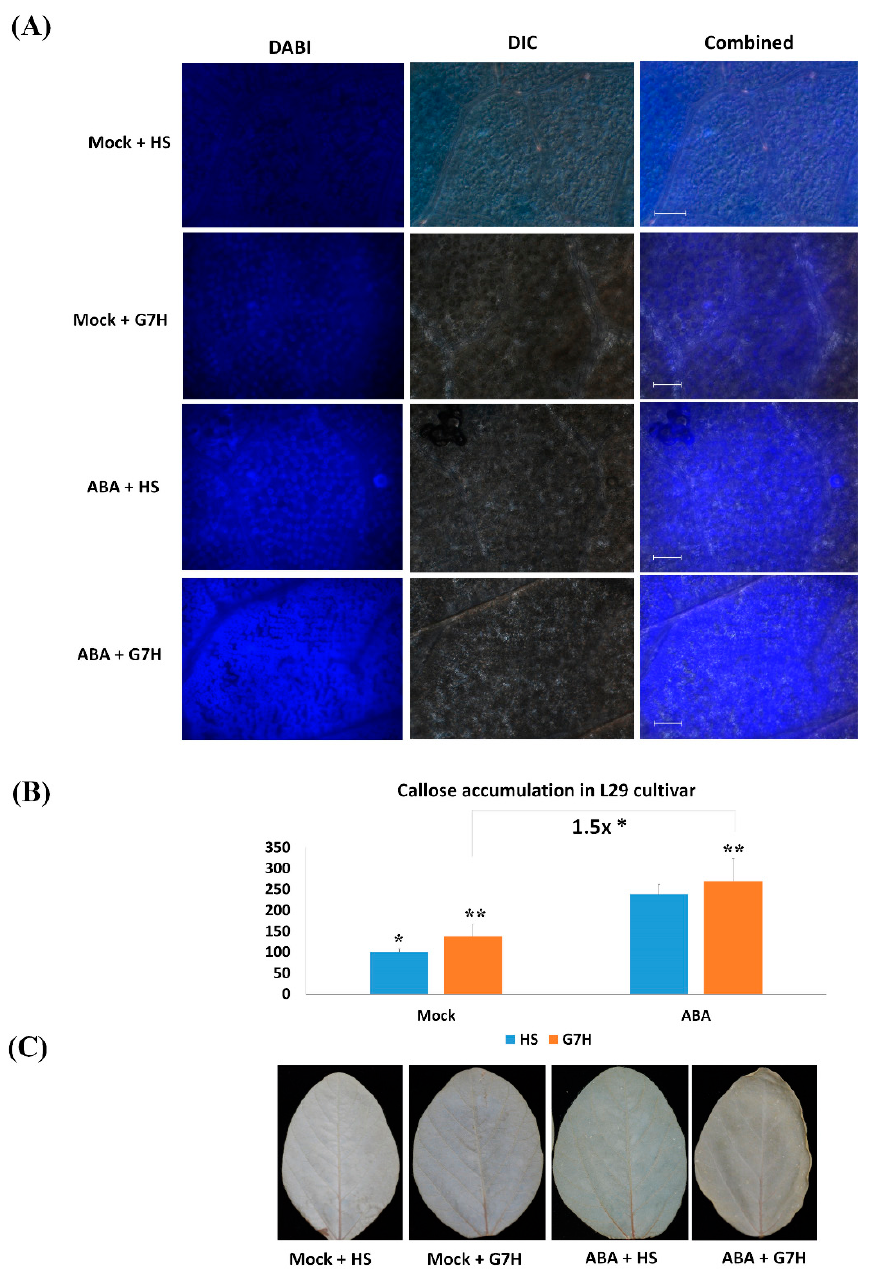
Figure 2. Levels of callose and reactive oxygen species (ROS) in L29 plants as affected by ABA treatment and G7H infection. L29 plants treated with Mock (0.1% MeOH) or with ABA (100 µM) were also treated with sap from healthy plants (HS) or sap from G7H-GFP-infected plants (G7H). Samples collected 5 dpi were subjected to aniline blue staining to reveal callose accumulation; scale bar = 20 µm ( A ). Callose fluorescence from aniline-blue-stained leaves was quantified using Image J software ( B ). ROS accumulation as indicated by DAB and as affected by ABA treatment, G7H-GFP infection, or both ( C ). The experiment was carried out in three independent replicates where values are means ± SD of three biological replicates, and statistical analysis was carried out as described in the legend of Figure 1, with additional comparison between Mock-G7H and ABA-G7H plants. * and ** indicate a significant difference at P < 0.05 and <0.01, respectively.